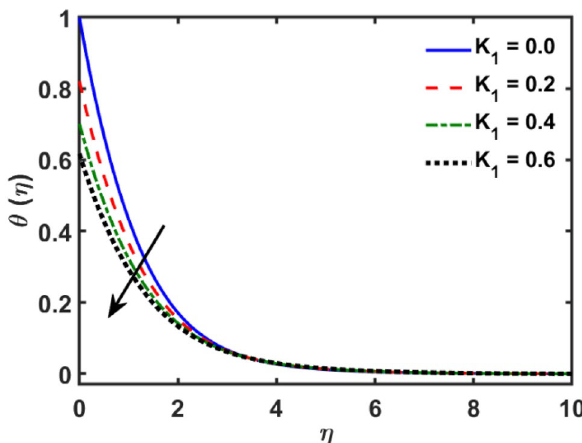
Figure 8. Variation of K 1 on θ(η) .